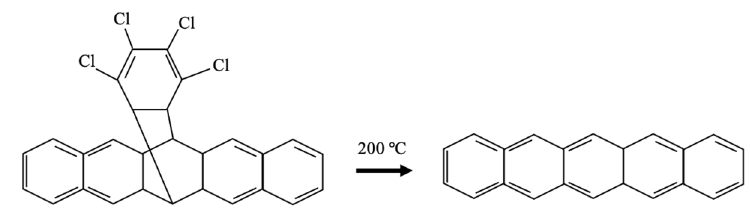
Figure 2. Example of a pentacene precursor structure.